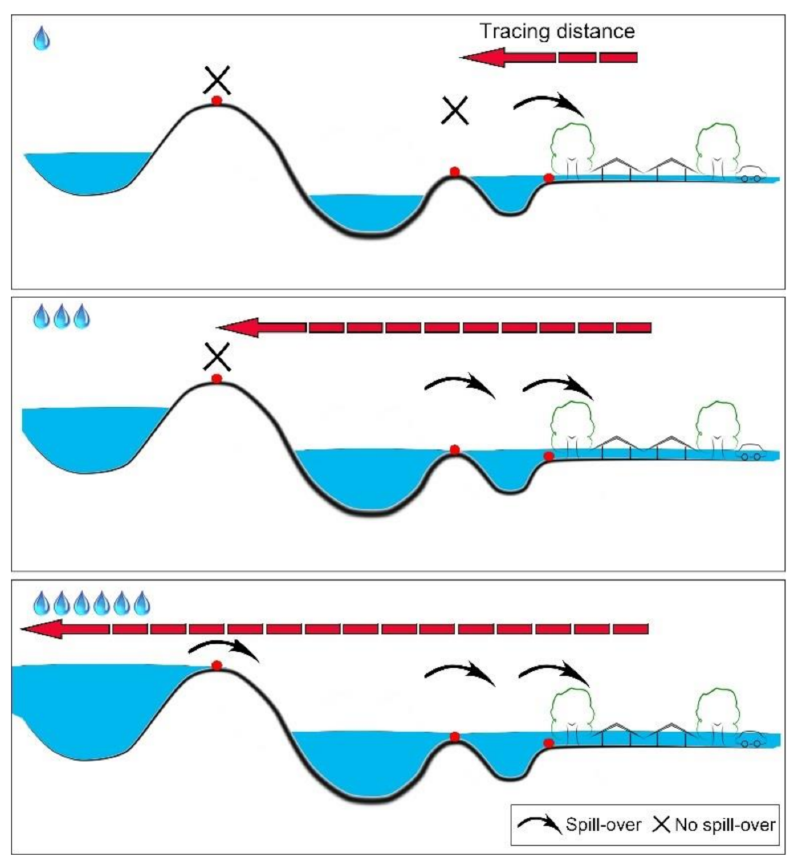
Figure 4. Targets-based upstream tracing procedure along stream links at various uniform rainfall scenarios, where the optimal tracing distance (red arrow) is determined from the continuity of overland flow based on spill-over and non-spill-over properties. Note: The number of raindrops represents the rainfall’s magnitude and No spill-over refers to the termination criterion to stop further upstream tracing. In case of a distributed rainfall, various optimal tracing distance in relation to target objects should be